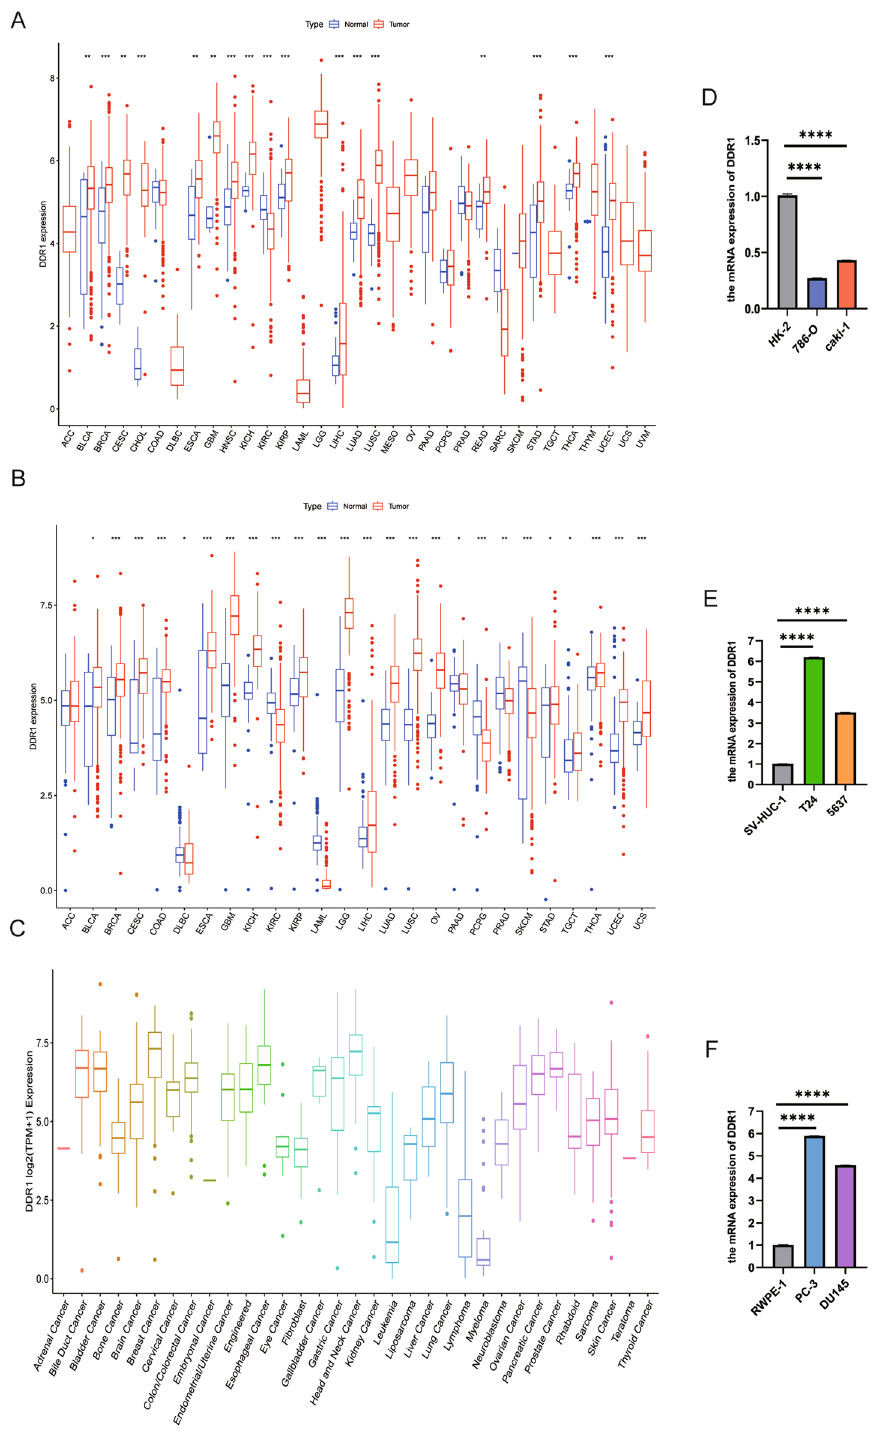
Figure 1. Differential expression of DDR1. ( A ) Comparison of DDR1 expression between tumor and normal samples in the TCGA database. ( B ) Comparison of DDR1 expression between tumor and normal samples in the TCGA and the GTEx databases. ( C ) DDR1 expression in tumor cell lines. * P < 0.05, ** P < 0.01, *** P < 0.001. ( D–F ) The expression level of DDR1 was evaluated in clear cell renal cell carcinoma (ccRCC), bladder cancer (BCa), and prostate cancer (PCa) cells and their corresponding normal cells by